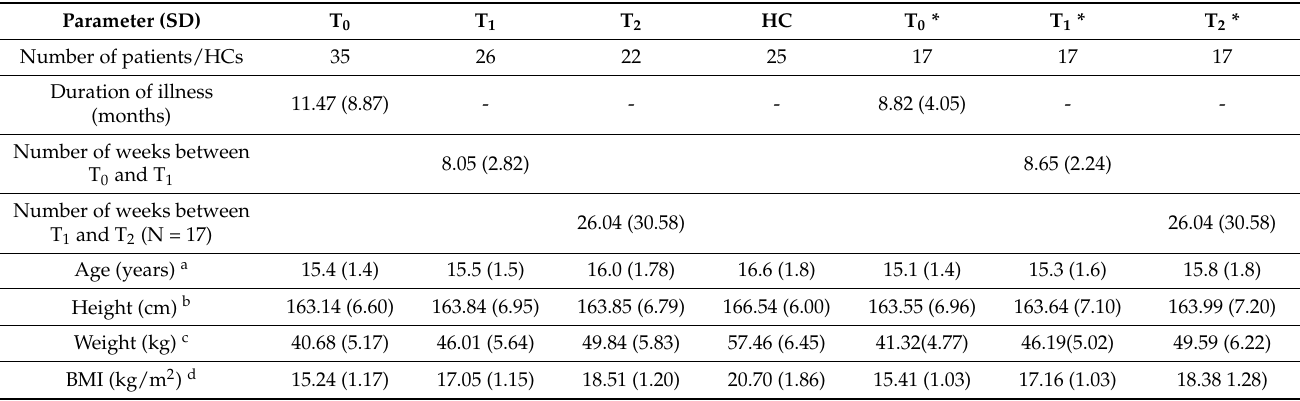
Table 1. Characteristics (mean, SD) of the entire study population/* the subset of patients with all measurement points and of healthy controls. Group comparisons T 0 vs. HC (N = 35, N = 25) were performed with the T